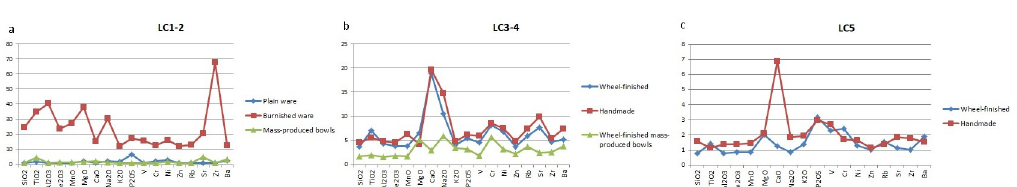
Fig 11. Relationships between elemental variances and ceramic wares/manufacturing techniques found in the LC1-2 (a), LC3-4 (b) and LC5(c).